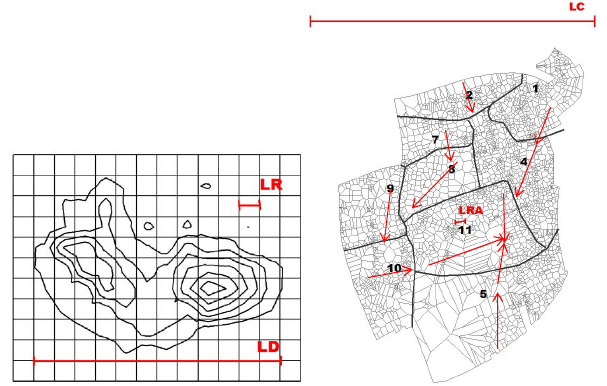
Figure 4. Storm de-correlation length ( L D ) and rainfall resolution ( L R ) in left panel. Catchment length ( L C ) , runoff length ( L RA ) in right panel; the catchment is divided into 11 independent subcatch- ments. Red arrows represent main flow directions. Runoff areas are also displayed, their average size is reported in Table